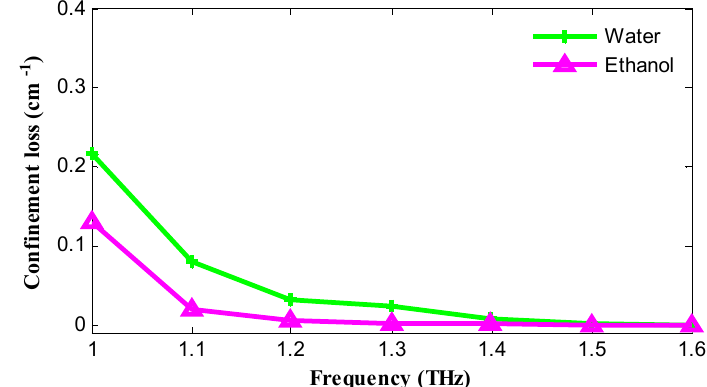
Figure 7. Confinement loss of water-filled (green) and ethanol-filled (pink) core PCF as a function of frequency.